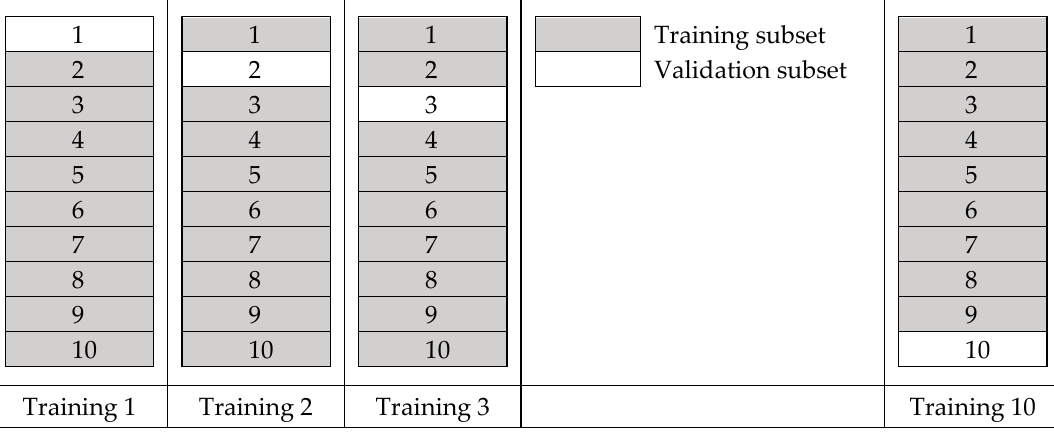
Figure 4. Combinations of the training set and validation set.